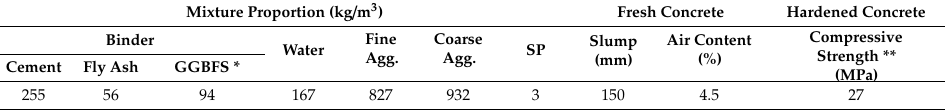
Table 3. Mixture proportions and properties of fresh and hardened concrete.